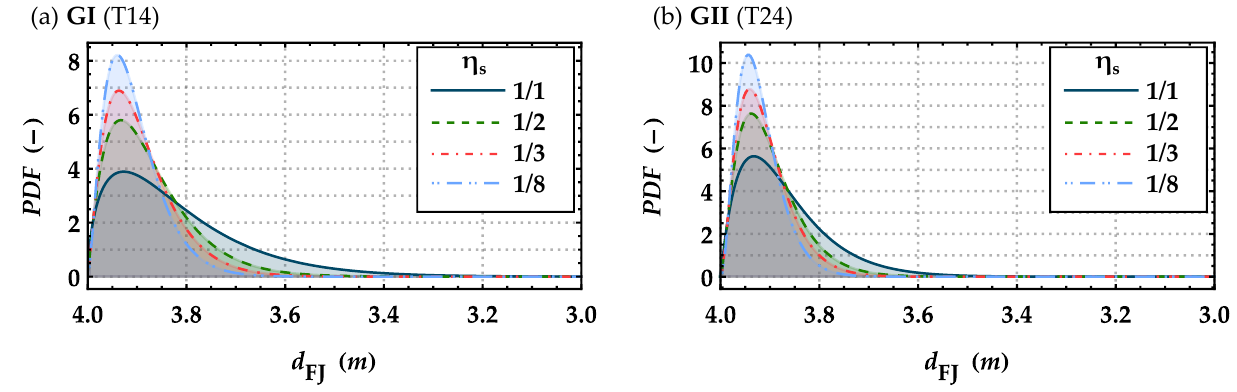
Figure 16. Calibrated beta density functions {0;4} for representing the distances between finger joints d FJ placed in boards as well as lengthwise split boards featuring different separation ratios of η s = {1; 1/2; 1/3; 1/8}, assuming a reference board length of l b = 4 m for base material of ( a ) GI (T14) and ( b ) GII (T24); for each setting 1.5 × 10 4 simulations.